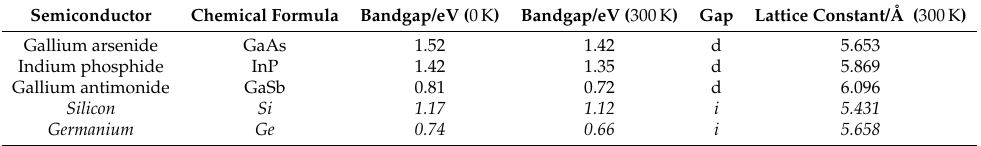
Table 1. Currently and commonly used materials for III–V compound solar cells, their bandgap E g at 0K and 300K, type of the structure ( d direct or i indirect) and the lattice constant at 300K. Germanium and silicon are also given below for the comparison written in italics